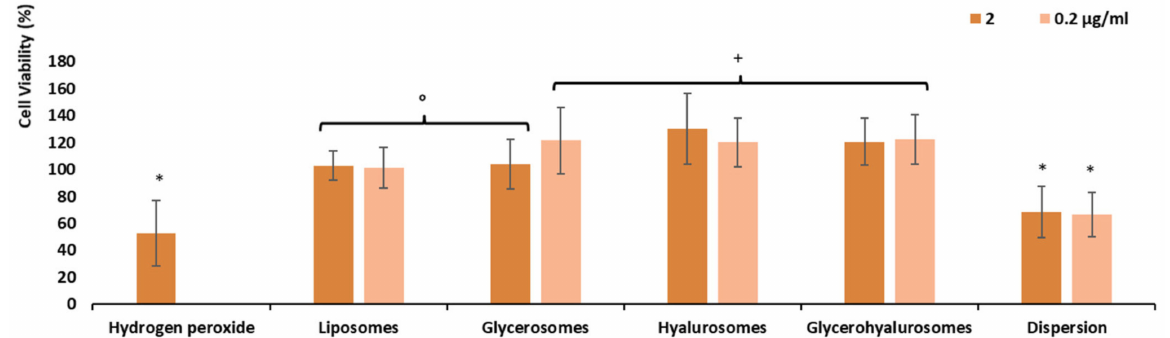
Figure 5. Viability of fibroblasts stressed with hydrogen peroxide and protected with canthaxanthin (2 µ g/mL and 0.2 µ g/mL) in dispersion or loaded in vesicles. Data are reported as mean values ( n = 9) ± standard deviations (error bars) of cell viability expressed as the percentage of untreated cells (100% viability). Each symbol (*, ◦ , + ) indicates the same value ( p > 0.05 versus